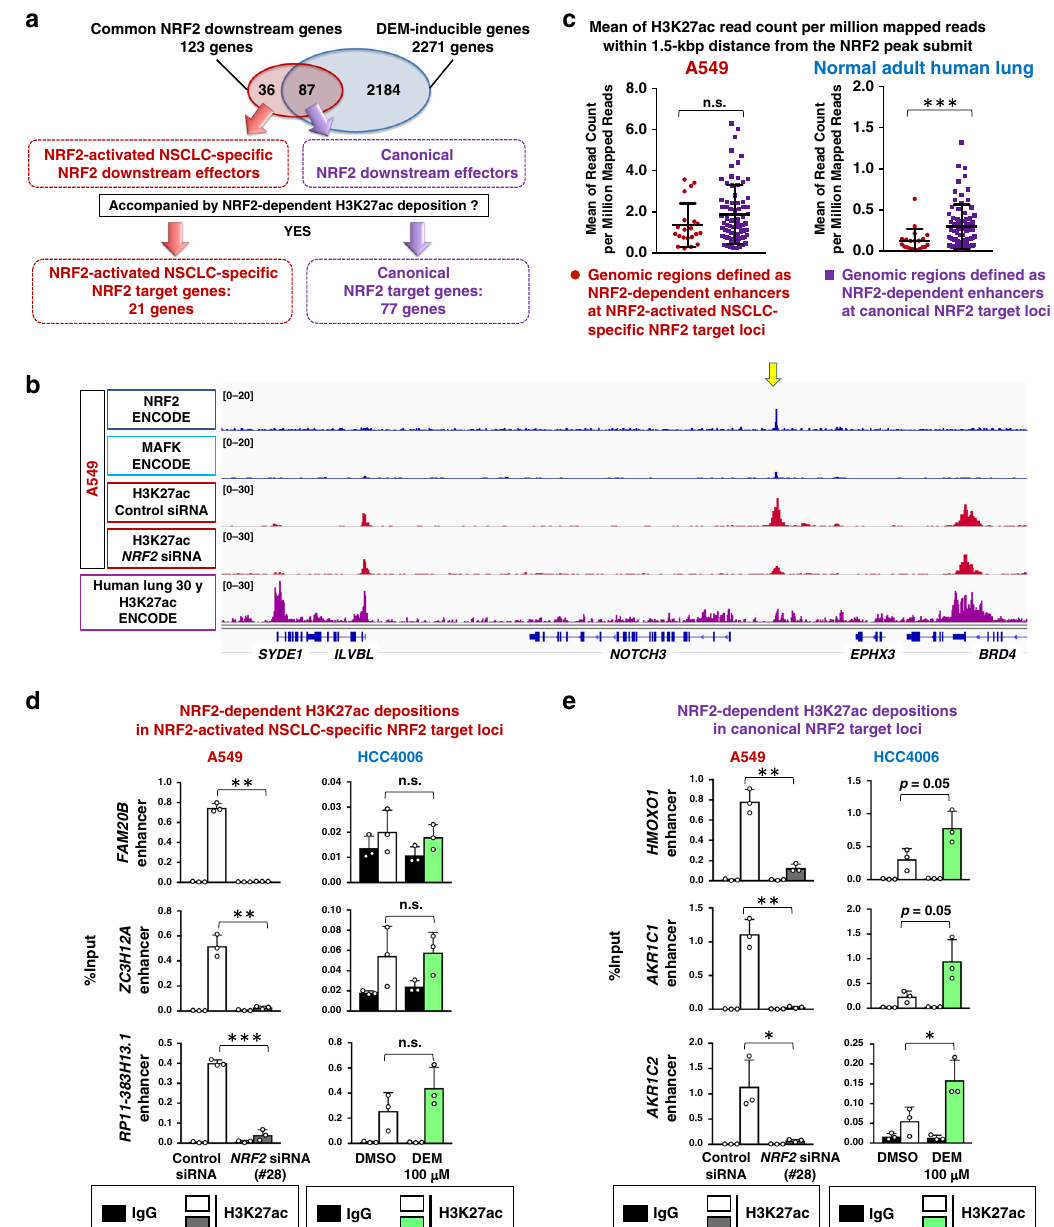
Fig. 5 NRF2-activated NSCLC possesses unique enhancer signatures. a NRF2-activated cancer-speci fi c NRF2 target genes and canonical NRF2 target genes based on the presence of NRF2-dependent enhancers. b ChIP-seq pro fi les at the NOTCH3 locus. A549 cells (upper panels) and normal adult human lung sample (lower panel) are shown. NRF2 and MAFK chromatin binding in A549 cells and H3K27ac deposition pattern in normal human lung sample were obtained from the ENCODE database. Acetylated H3K27 deposition pro fi les in A549 cells treated with control siRNA or NRF2 siRNA were obtained in this study. A yellow arrow indicates NRF2-dependent H3K27ac deposition . c Comparison of H3K27ac deposition in NRF2-dependent enhancers that were de fi ned in A549 cells. The NRF2-dependent enhancers were classi fi ed into two groups: those within NRF2-activated NSCLC-speci fi c NRF2 target loci and those within canonical NRF2 target loci. H3K27ac deposition in A549 cells was compared between these two groups using merged results of three independent experiments (left panel). Similar comparison was conducted using normal adult human lung samples in ENCODE database (right panel). Two- tailed Mann – Whitney test was performed. *** p < 0.0005, n.s.: not signi fi cant. d , e ChIP assay using the H3K27ac antibody in A549 cells treated with control or NRF2 siRNA and HCC4006 cells treated with vehicle (DMSO) or DEM. H3K27ac deposition at NRF2-activated NSCLC-speci fi c NRF2 target loci ( d ) and canonical NRF2 target loci ( e ) were examined. The average and SD of three independent experiments are shown. Two-sided Student ’ s t test was performed. * p < 0.05, ** p < 0.005, *** p < 0.0005, n.s.: not signi fi cant. DMSO: dimethyl sulfoxide, DEM: roles of the transcription factor has not been well understood NRF2 for transcriptional activation of non-canonical target genes. under physiological conditions and in the context where it serves Based on the close proximity between AREs and a CEBPB as a cancer driver. In this study, we found that CEBPB is one of binding motif in the NOTCH3 enhancer region, NRF2 and the factors that alter NRF2 function in NRF2-activated NSCLC; CEBPB appear to bind to DNA as distinct dimers with MAFK (or CEBPB is involved in the enhancer remodeling that invigorates other small MAF) and C/EBP family members, respectively.